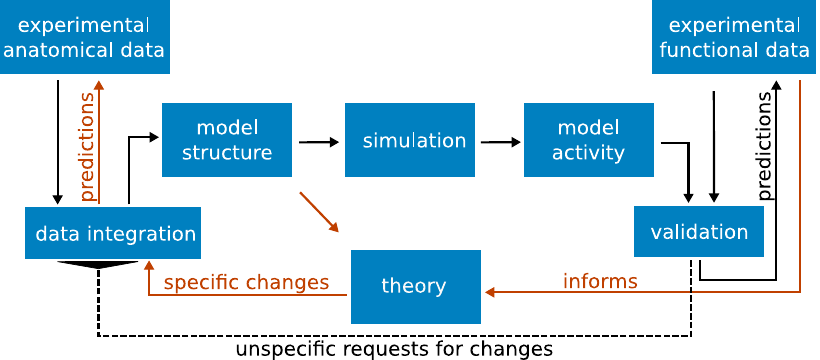
Fig 1. The integrative loop between experiment, model, and theory. Black arrows represent the classical forward modelingapproach: Experimental anatomicaldata are integratedinto a model structure, which gives rise to the activity via simulation. The model activity is comparedwith experimental functionaldata. The usual case of disagreement leads to the need to changethe model definition. By experience and intuitionthe researcher identifies the parameters to be changed, proceeding in an iterative fashion. Once the model agreeswell with a number of experimental findings,it may also generatepredictions on the outcome of new experiments. Red arrows symbolize our new approach: informed by functionaldata, an analyticaltheory of the model identifies critical connections to be modified,refiningthe integration of data into a consistent model structure and generatingpredictions for